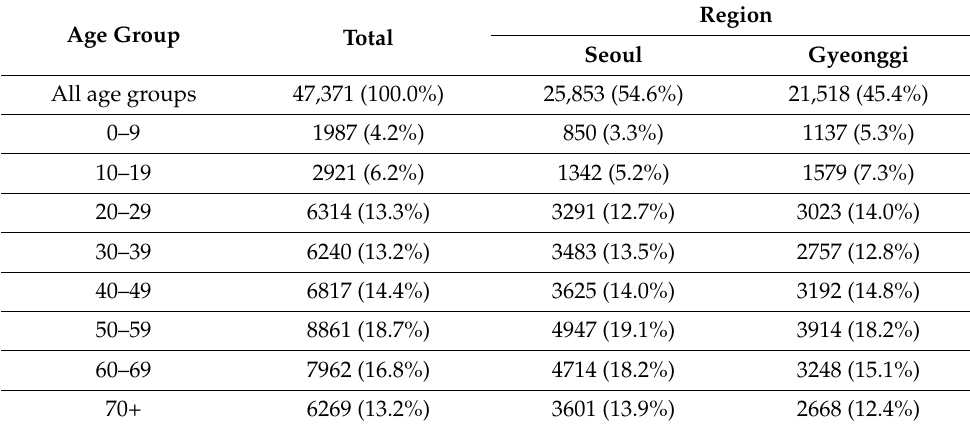
Figure 1. Confirmed cases in Seoul/Gyeonggi area. Table 2. Confirmed cases in Seoul/Gyeonggi